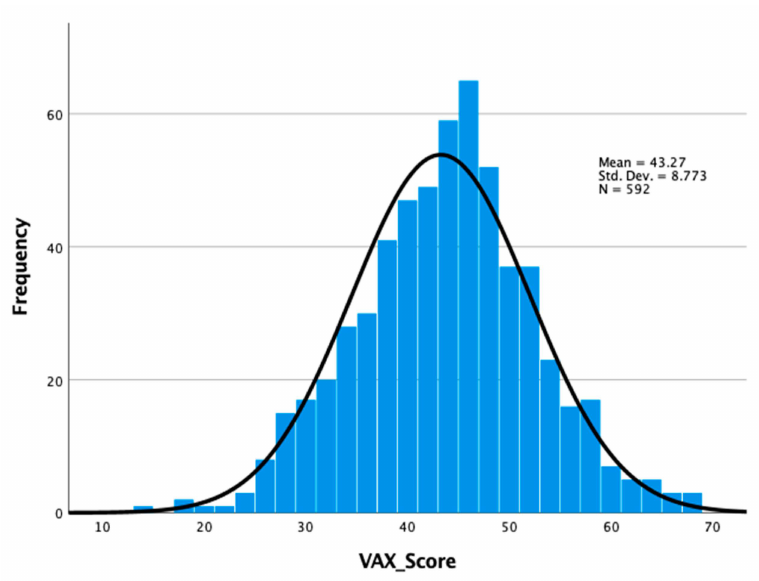
Figure 1. Distribution of VAX